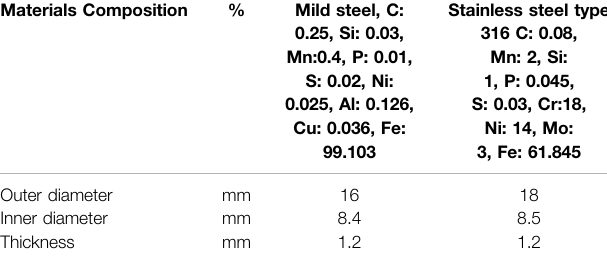
TABLE 1 | Mild steel and stainless steel 316 compositions. Materials